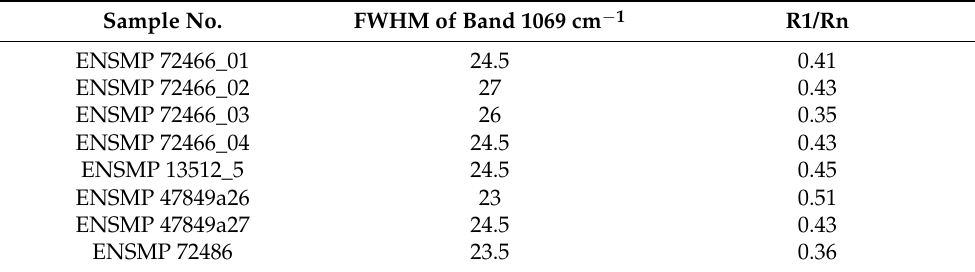
Figure 6. Micro-Raman spectra from Egyptian emeralds (using 514 laser excitation). ( a ) Raman spectra from 200 to 1300 cm − 1 of a single-crystal emerald (ENSMP 72466_02) parallel (red line) and perpendicular (black line) to c-axis. Characteristic peaks at 686 and 1069 cm − 1 are observed, while the 1069 cm − 1 peak is more intensely parallel to c-axis. ( b ) Raman spectra from 3500 to 3700 cm − 1 of a single-crystal emerald (ENSMP 72466_01) parallel (red line) and perpendicular (black line) to c-axis. Peak close to 3608 cm − 1 is related with Type I water molecule structure. More intense bands at 3598 cm − 1 are due to Type II water molecule structure with an alkali ion nearby. ( c ) Raman spectra from 200 to 1300 cm − 1 of emeralds from samples that are included in the host rock. Spectra were acquired with the laser beam perpendicular to the prism facets. ( d ) Raman spectra from 3500 to 3700 cm − 1 of the samples ENSMP 47849a27 (black line) and ENSMP 47840a26 (grey line). The intense band at 3598 cm − 1 is related with Type II water molecules with an alkali ion nearby. Table 2. Position and FWHM of the Raman band at around 1069 cm − 1 , relative intensities of the Raman bands at 3598 cm − 1 and 3608 cm − 1 and position of the R1 photoluminescence bands for the samples of different localities. All observations were made using spectra acquired with a laser beam parallel and/or perpendicular to c-axis.